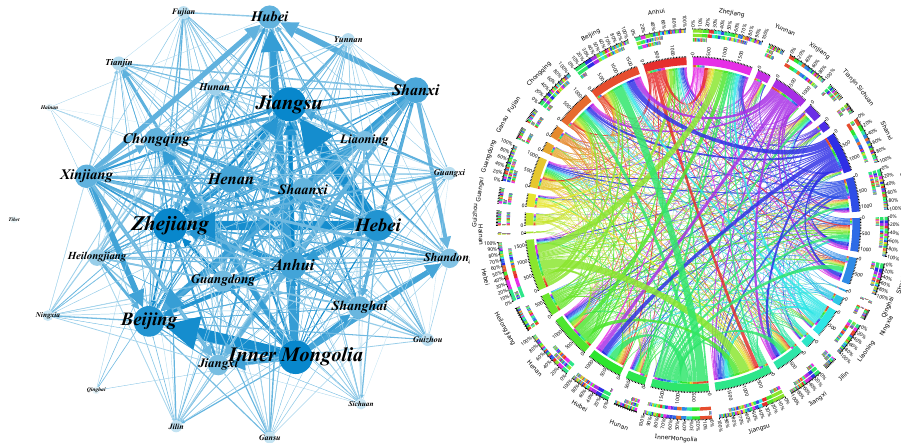
Figure 6. Inter-provincial embodied carbon emission transfers in 2015.